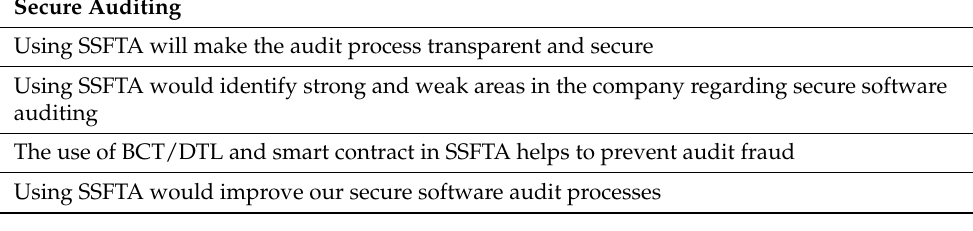
Table 4. The questions to evaluate SSFTA secure auditing characteristics.